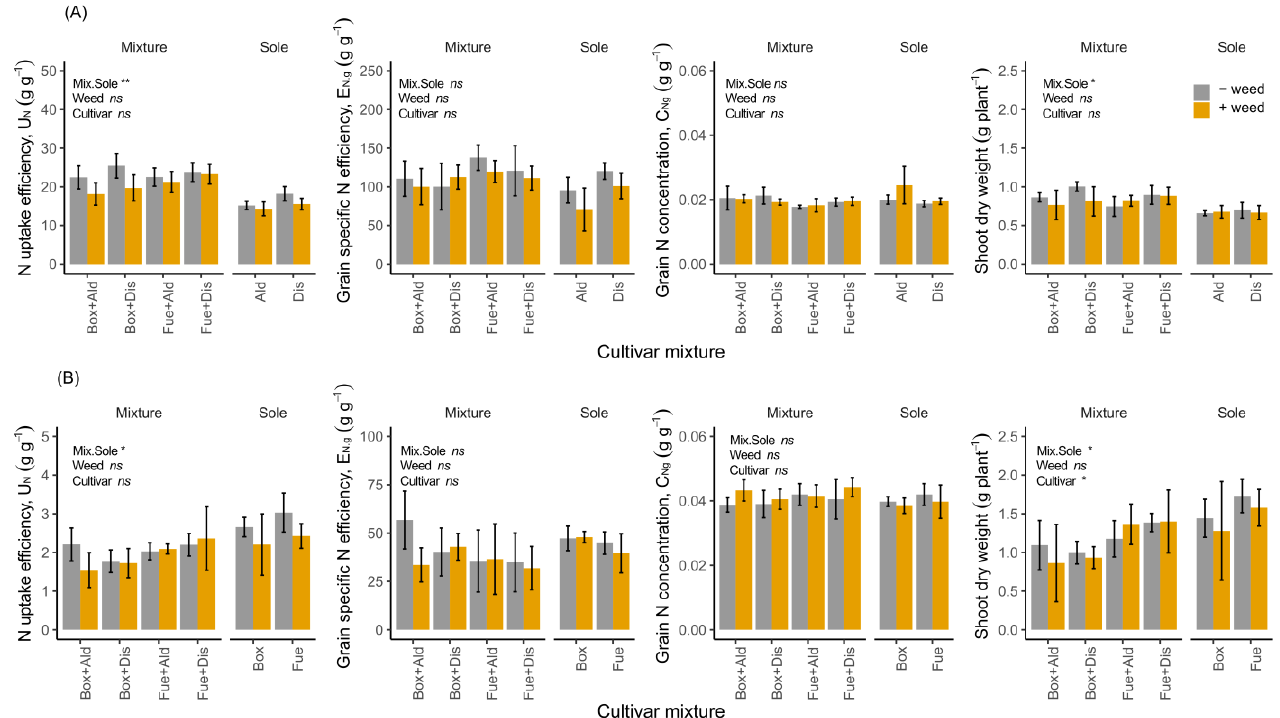
Figure 3. Nitrogen accumulation efficiency (NAE) components for cereals ( A ) and legumes ( B ), showing N uptake efficiency (U N ), grain specific N efficiency, E N,g ), grain N concentration (C N,g ) and shoot dry weight at flowering. The different cereal and legume cultivars were pot-grown as sole crops and mixtures, with (+weed) and without ( −weed ) C. album . The full cultivar names are the same as in Figure 2. Symbols show ANOVA results with significant levels: ** = p ≤ 0.01; * = p ≤ 0.05; and ns= non-significant. Error bars represent ±1SD.